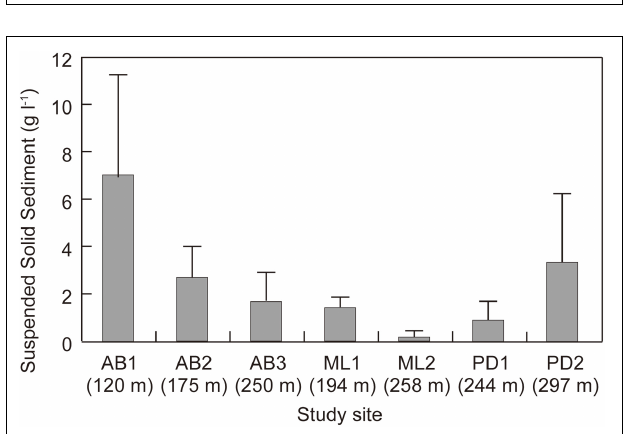
FIGURE 3 | Suspended solid sediment in surface ice at the study sites on three glaciers in Svalbard.